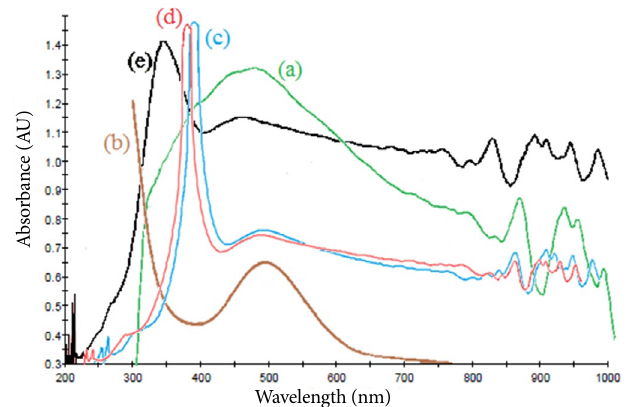
Fig. 3. Optical absorption spectrum of (a) Pure Au, (b) Pure Cu, (c) 10% Cu, (d) 25% Cuand (e) 50% Cu.